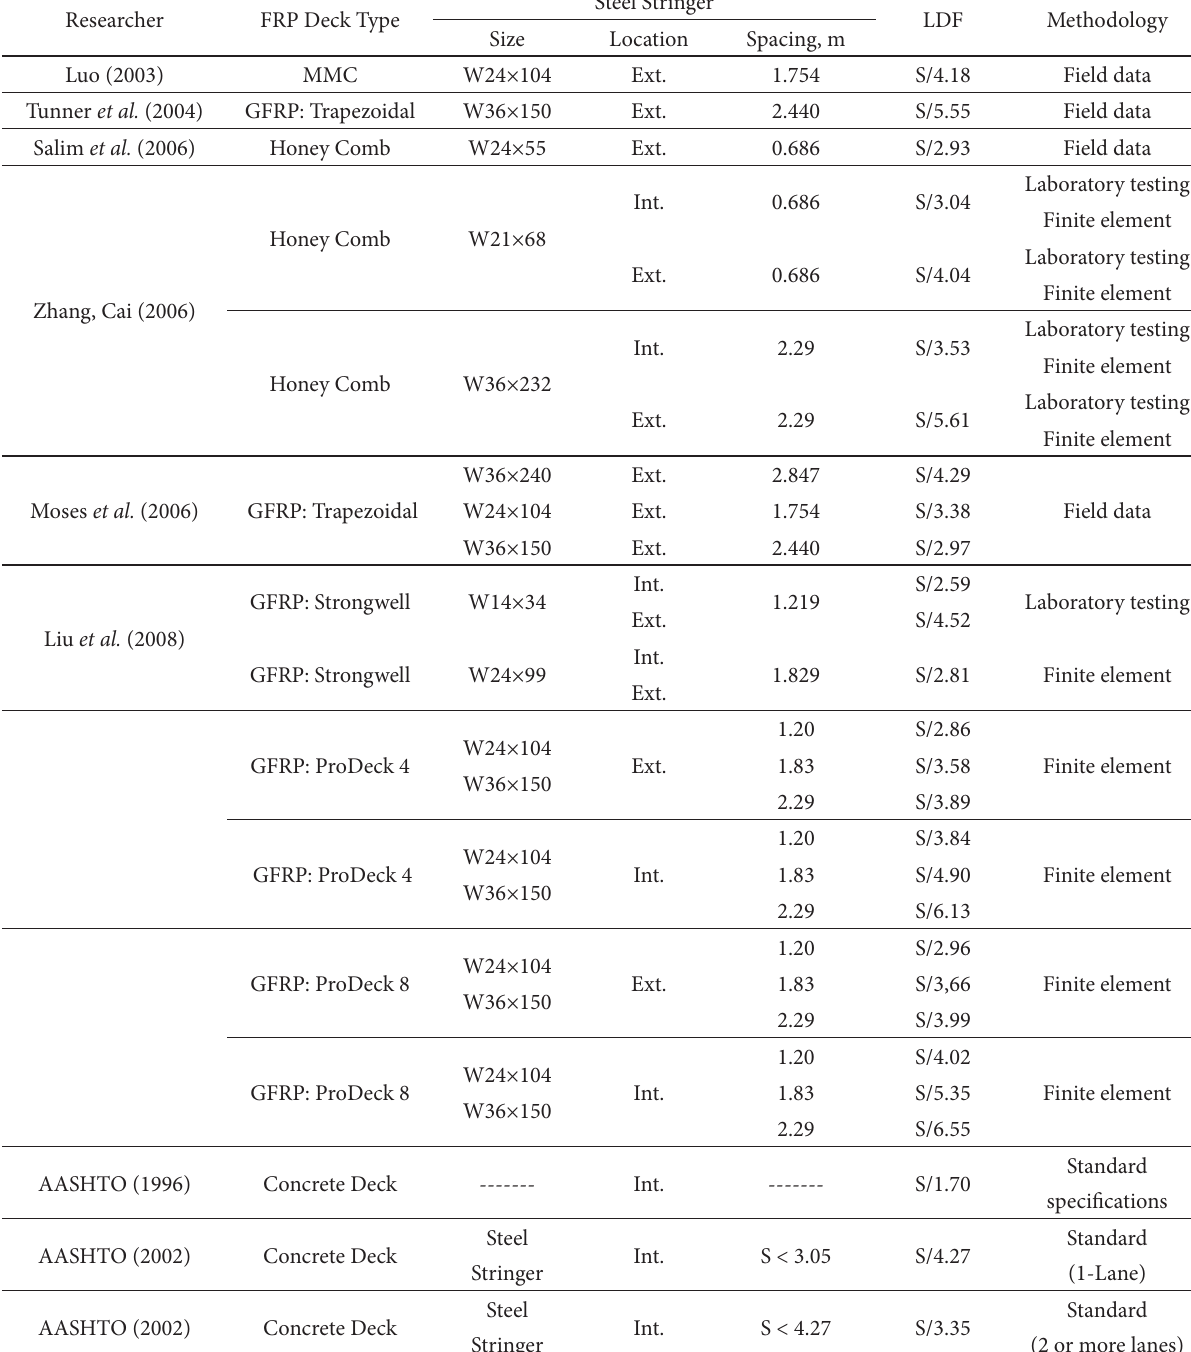
Table 4. Load distribution factors of FRP deck-steel stringer bridges